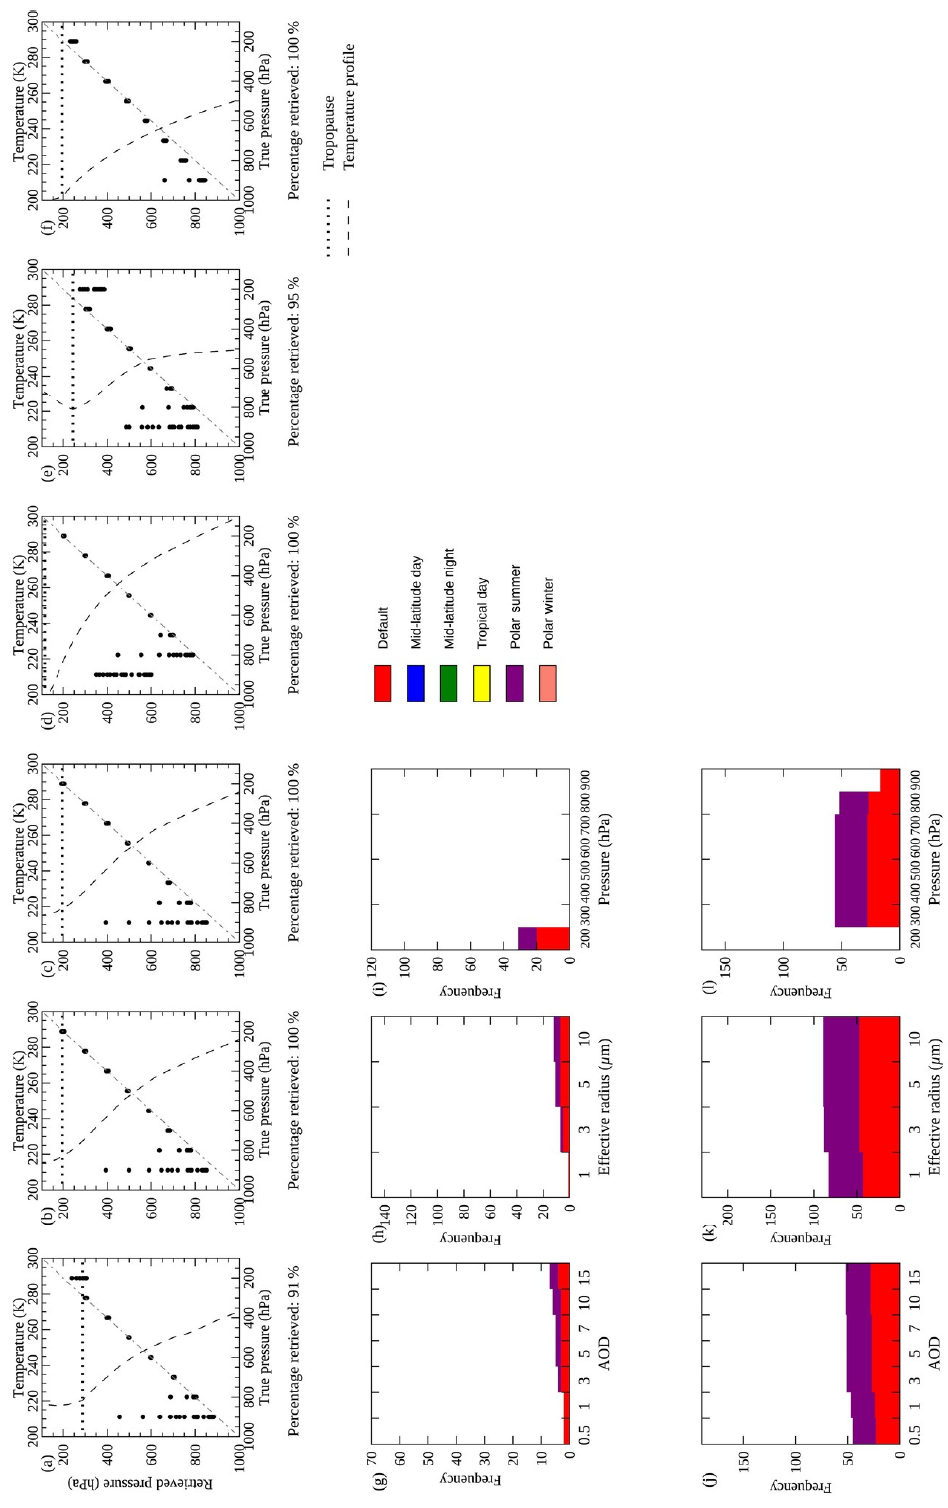
Figure A7. Same as Fig. 6 without a quality control